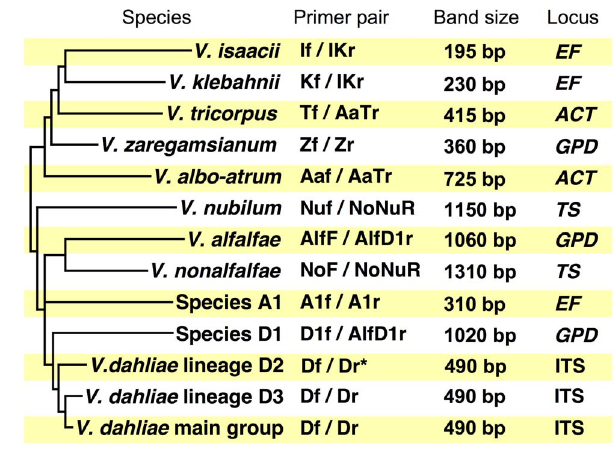
Figure 2. Specificity, expected band sizes and target loci of the eleven PCR primer pairs designed in this study. Phylogenetic tree on the left summarizes relationships of Verticillium species from Inderbitzin et al. [4,47], branch lengths are not to scale. The asterisks indicates that primer pair Df/Dr only amplifies V. dahliae strains of V. dahliae lineage D2, but not strains of V. longisporum lineage A1/D2 (Figure 1). For details see text.